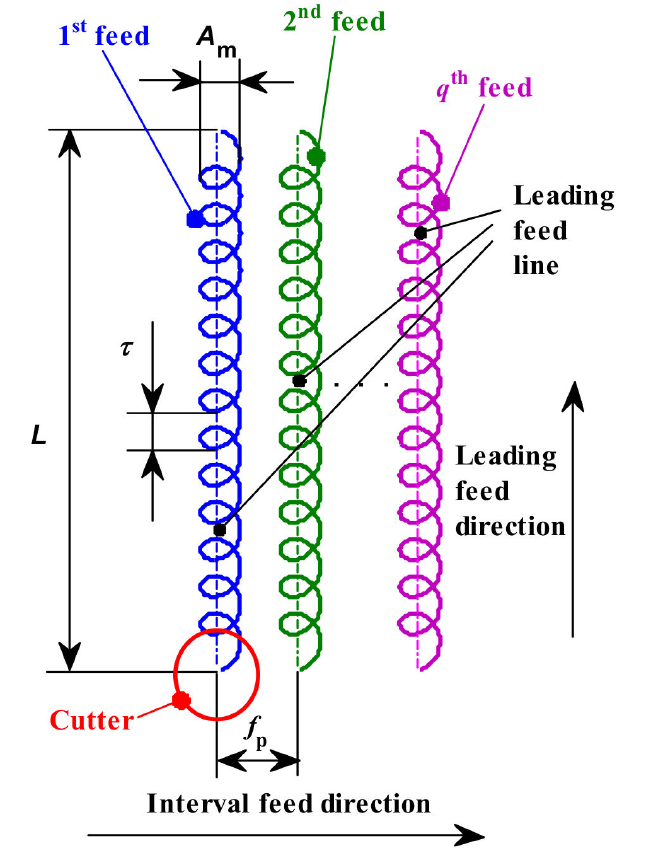
Figure 3. Feed trajectory of trochoidal